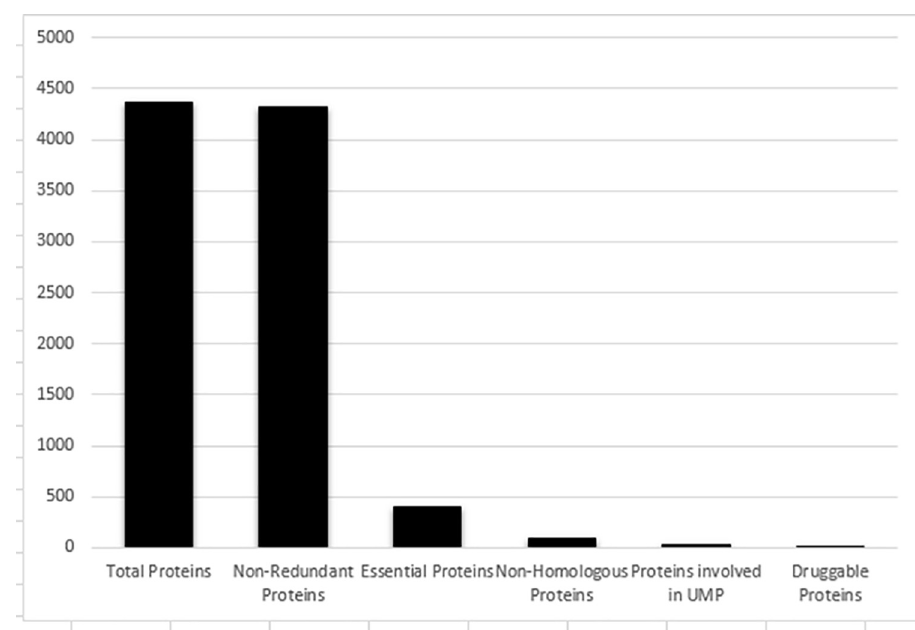
Fig 2. Summary for the detection of novel drug targets in S . maltophilia . This shows protein counts of selected paralogous sequences, essential proteins, non-homologous proteins and drug target proteins.